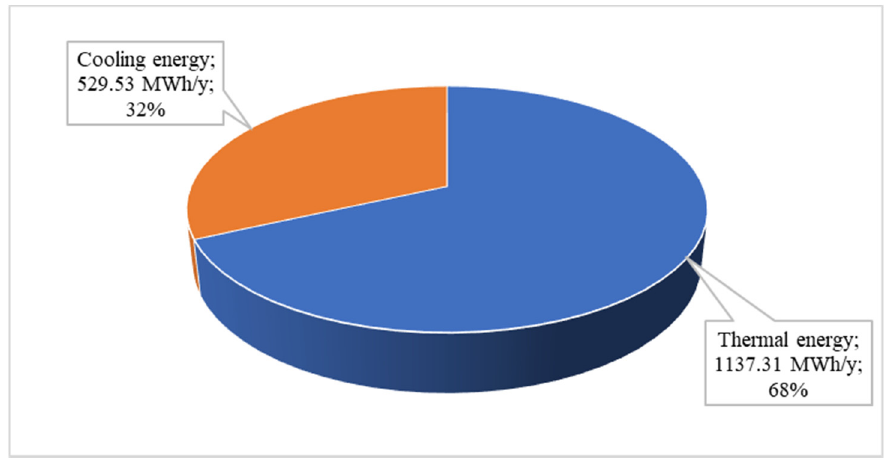
Figure 12. Distributed thermal and cooling energy.